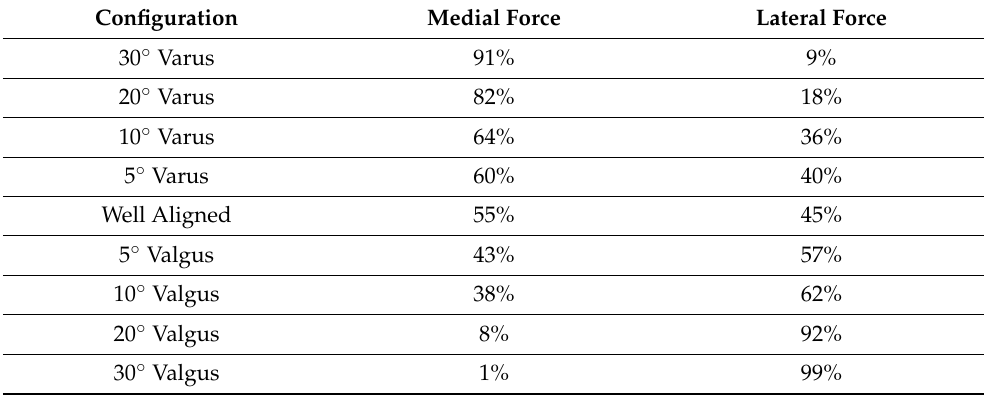
Table 3. Percentages of the total force applied in the different configurations analyzed in the study [11]. Configuration